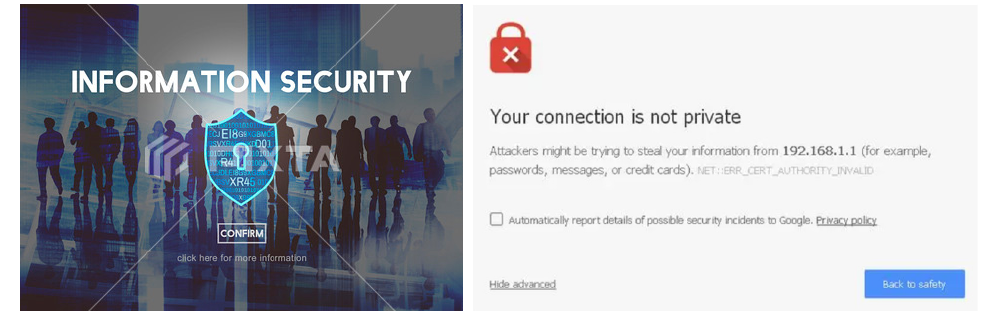
Figure 1. Security Notice Interface.